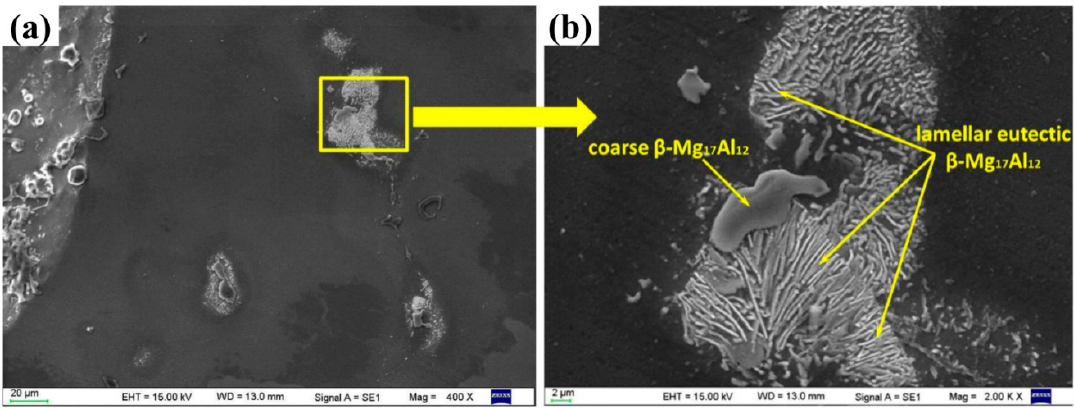
Figure 3. Morphologies of β -Mg 17 Al 12 ( a ) and the enlarged image of β -Mg 17 Al 12 ( b ) in the composite foams.